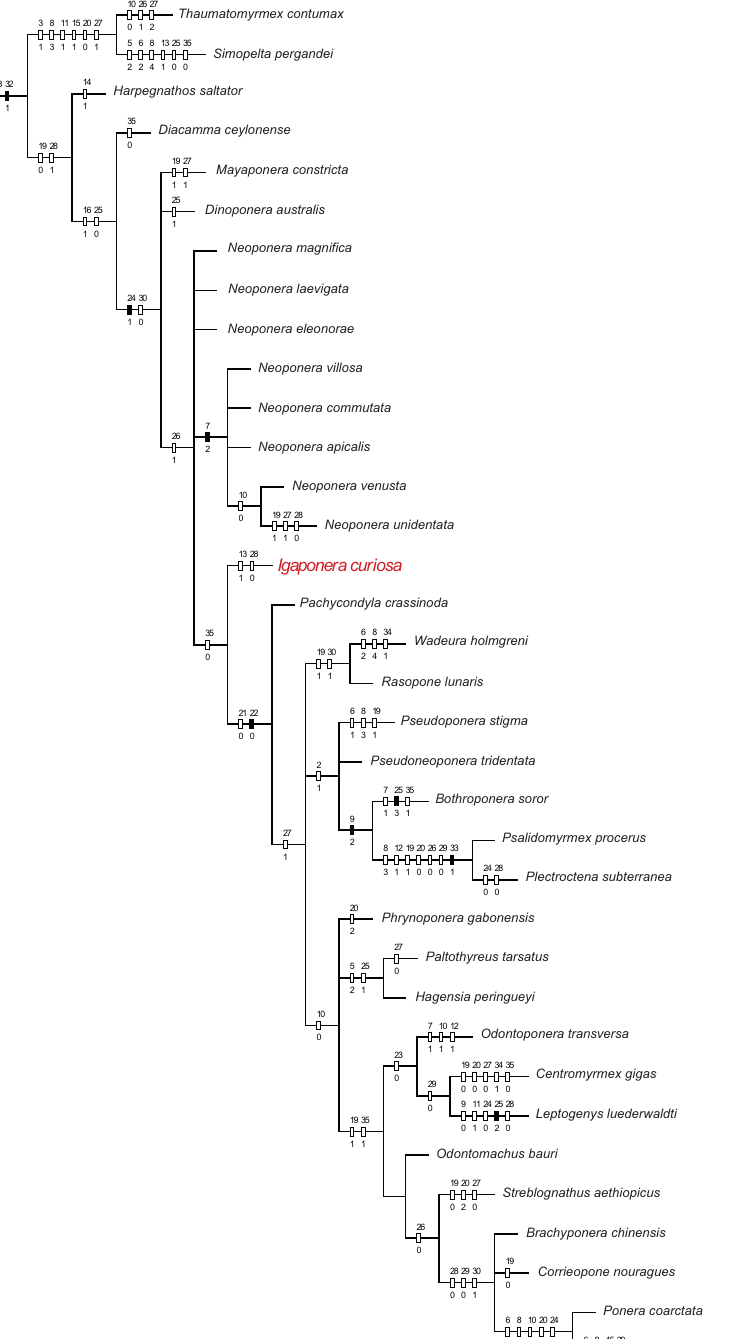
Fig. 2 . Strict consensus phylogeny, identical to that in Fig. 1B, obtained through maximum parsimony. The tree shows homoplastic (white square marks) and non-homoplastic (black square marks) apomorphies. Numbers above the marks represent the characters examined, and numbers below the marks represent character states (see also Supp. file